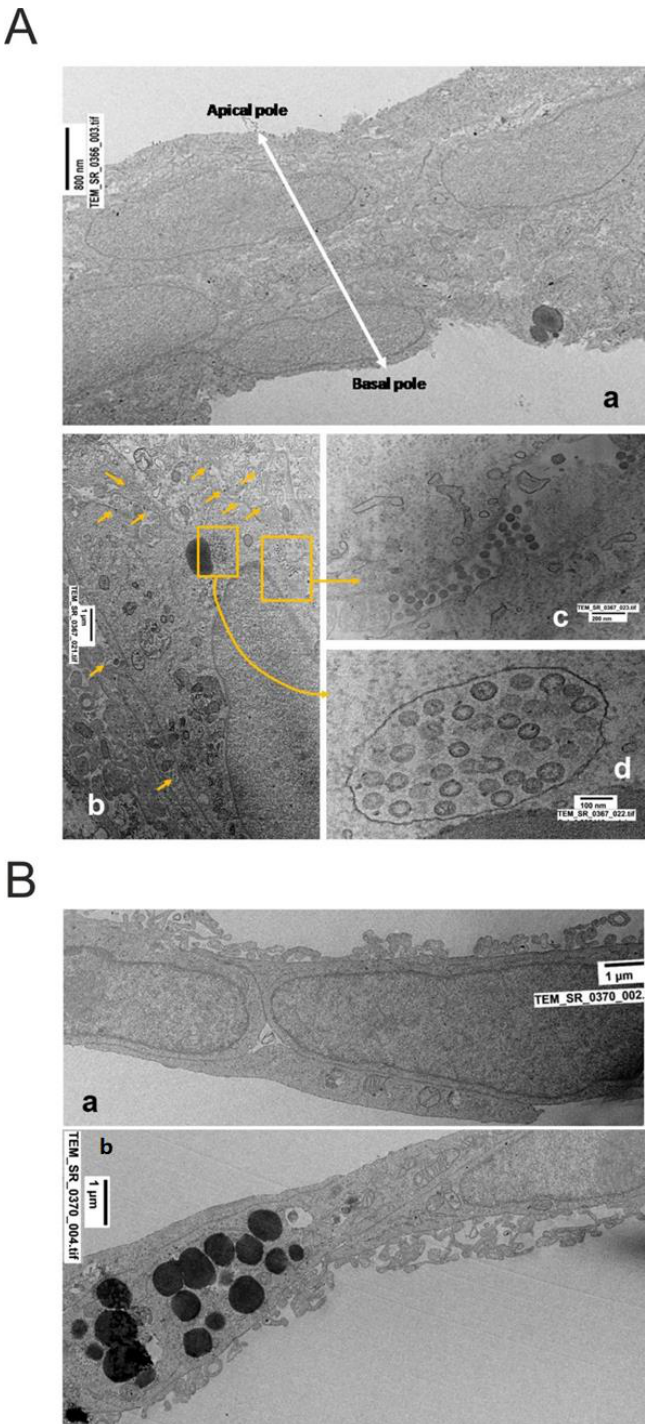
Figure 2. ( A ) ( a ) Control Vero E6 cells. ( b ) SARS-CoV-2 infected Vero E6 cells; ( c ) detail of virus particles in the extracellular space; ( d ) cytoplasmic vacuole containing numerous virus particles with spiky surfaces. Magnification is indicated by bars in each micrograph. For description see text . ( B ) ( a , b ) Control A549 cells. Two major subpopulations of cells were present; the first ( a ) was charac- terized by large nuclei and scarce cytoplasm, containing a few mitochondria and other organelles, with absent lipid bodies. The second type of cells ( b ) was larger with abundant cytoplasm containing numerous electron-dense granules (likely immature